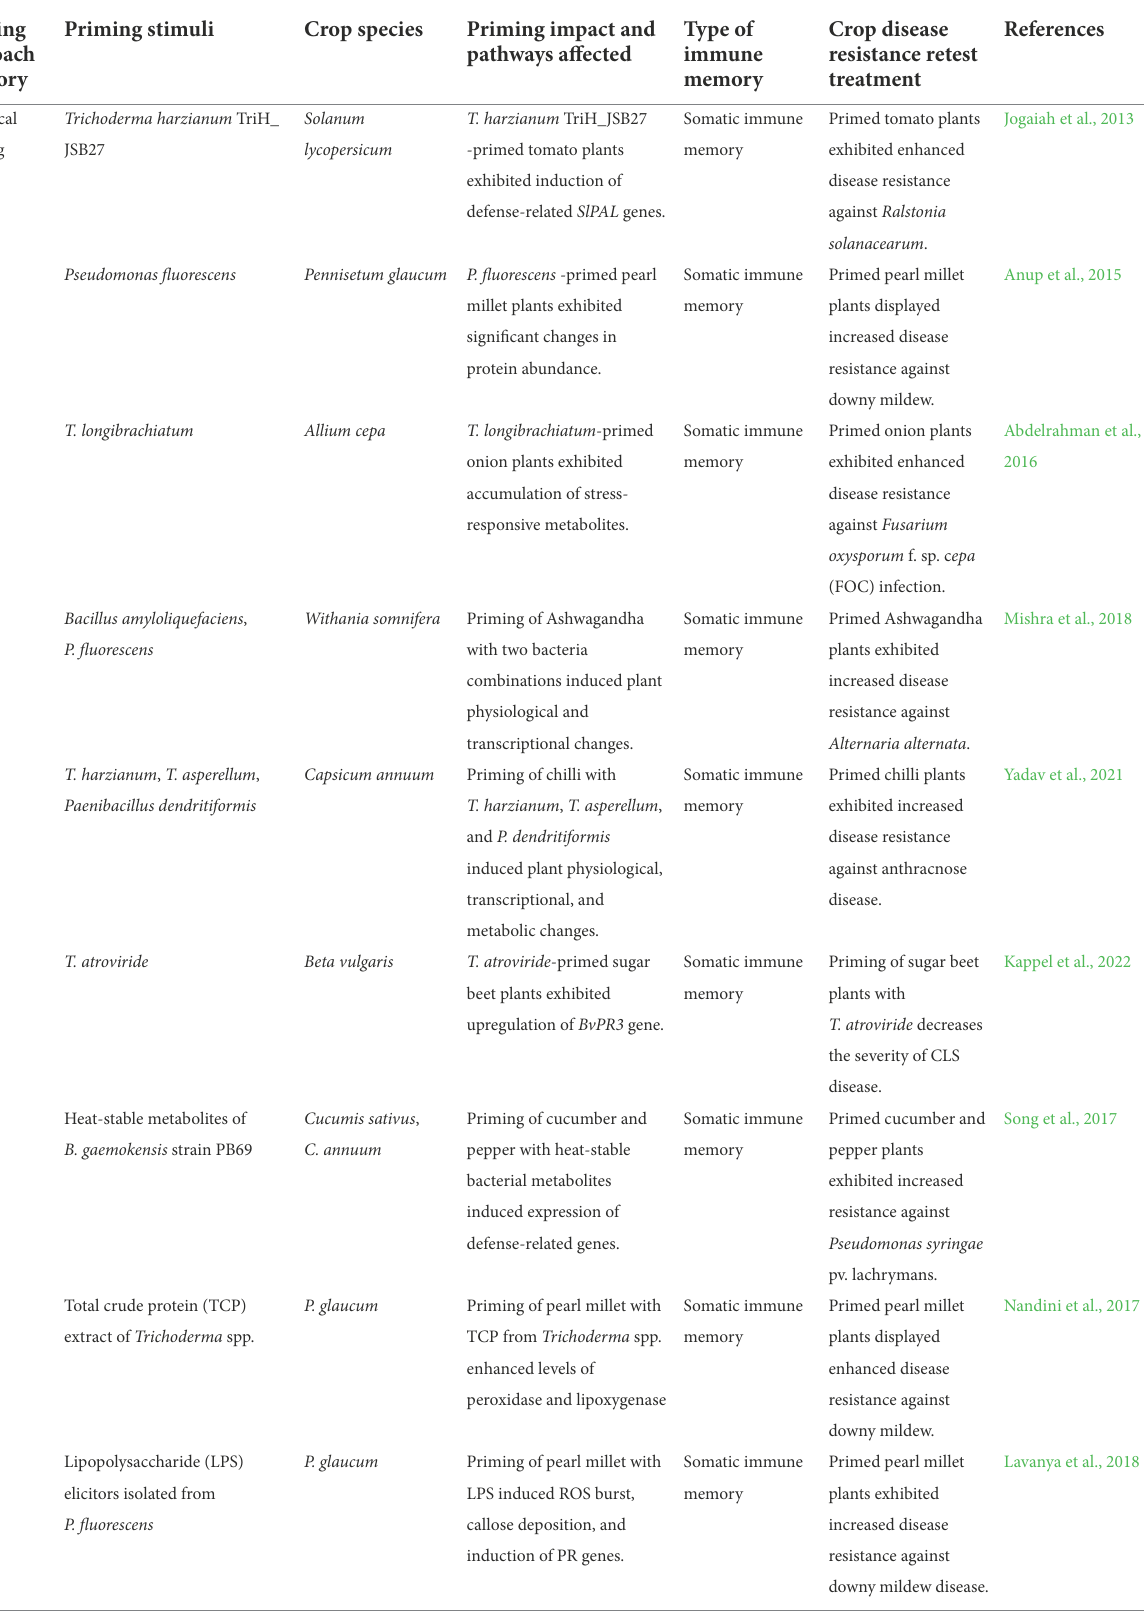
TABLE 1 Summary of seed priming approaches for crop disease resistance